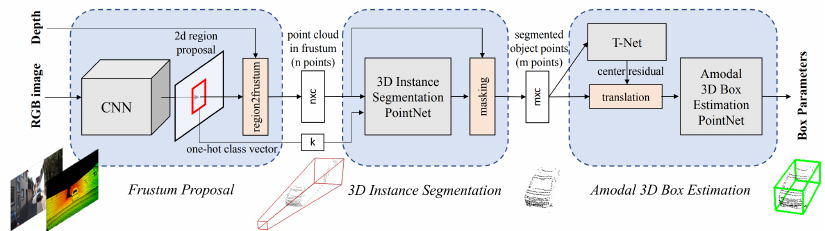
Figure 8. Frustum point net architecture. 2D CNN object detection is used to determine objects in RGB-D depth maps. Frustums are lifted from the 2D image to create a 3D point cloud search space. A PointNet instance segmentation network performs a binary segmentation for the predicted class (encoded in the one-hot-class vector). A t-net is used to refine the segmented points centroid to align close to ground truth bounding box centroid. Finally, a 3D amodal bounding box estimation is regressed, optimised using the novel corner loss function. All three networks are subsequently trained using a multitask loss function encompassing all three networks. Image source: